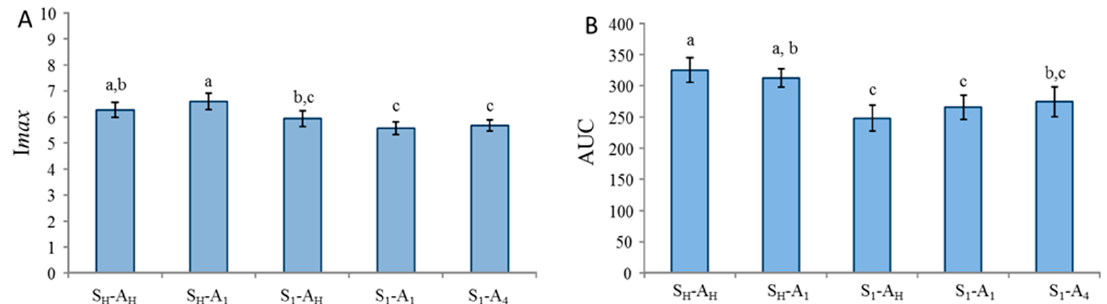
Figure 6. Mean I max : maximum intensity ( A ) and AUC: area under the curve ( B ) for the “quiche” aroma attribute. Every value represents the average over assessors and replications. Error bars represent standard error of the means. Identical letters indicate that the mean is not significantly different at a level of 5%. S H and A H : homogeneous distribution of salt and aroma, respectively. S n and A n : heterogeneous distribution of salt and aroma in layer n,